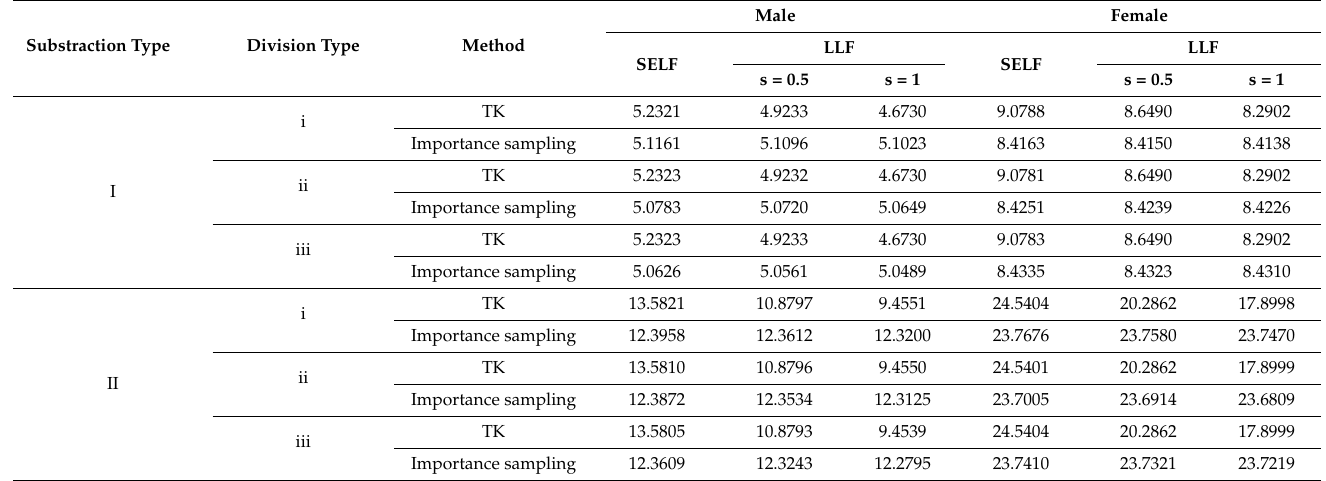
Table A9. The results of Bayesian estimates for λ using TK approximation and importance